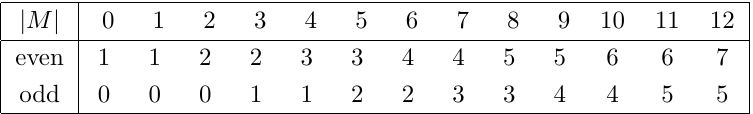
Table 1 . The total numbers of degenerate zero-modes for Z 2 -even and -odd wavefunctions.